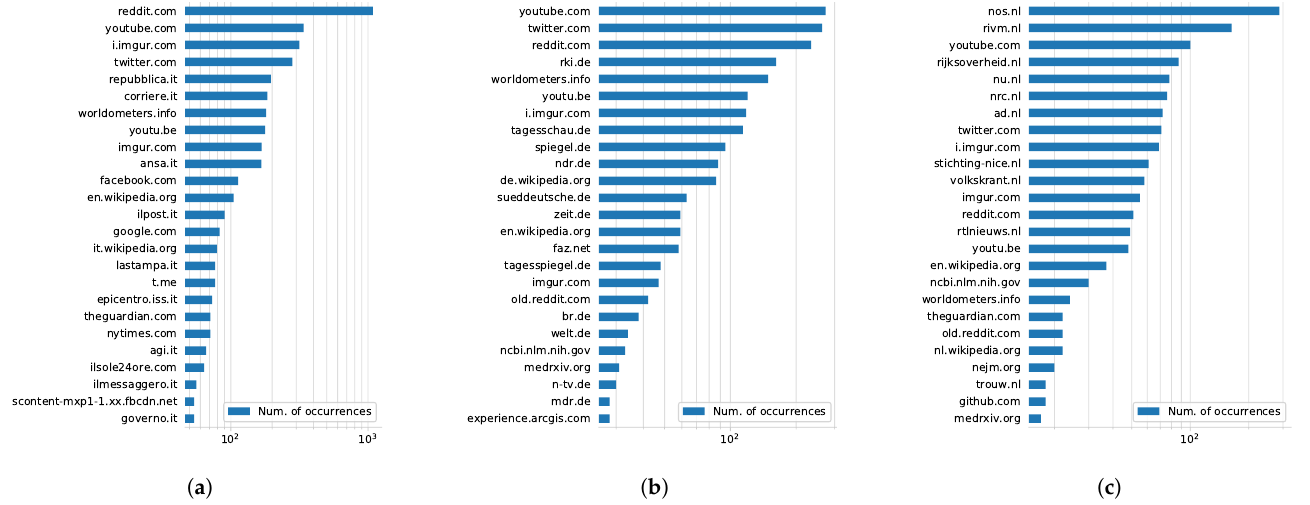
Figure 11. The top 25 most linked web domains in ( a ) /r/italy, ( b ) /r/de and ( c )